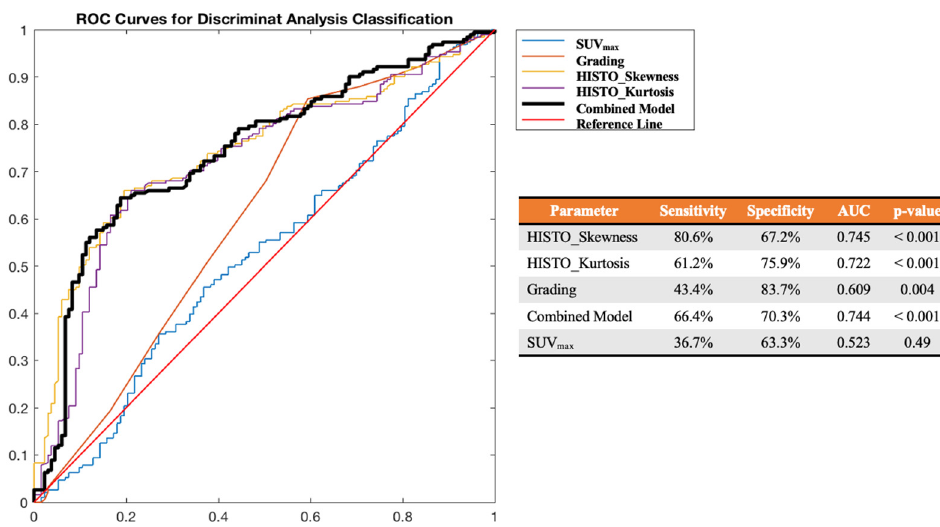
Figure 3. ROC curve analysis for HISTO_Skewness, HISTO_Kurtosis, Grading, their combination (Combined Model) and SUV max in the prediction of response to PRRT (early FU status) in terms of PD vs. positive results (SD, PR, CR).